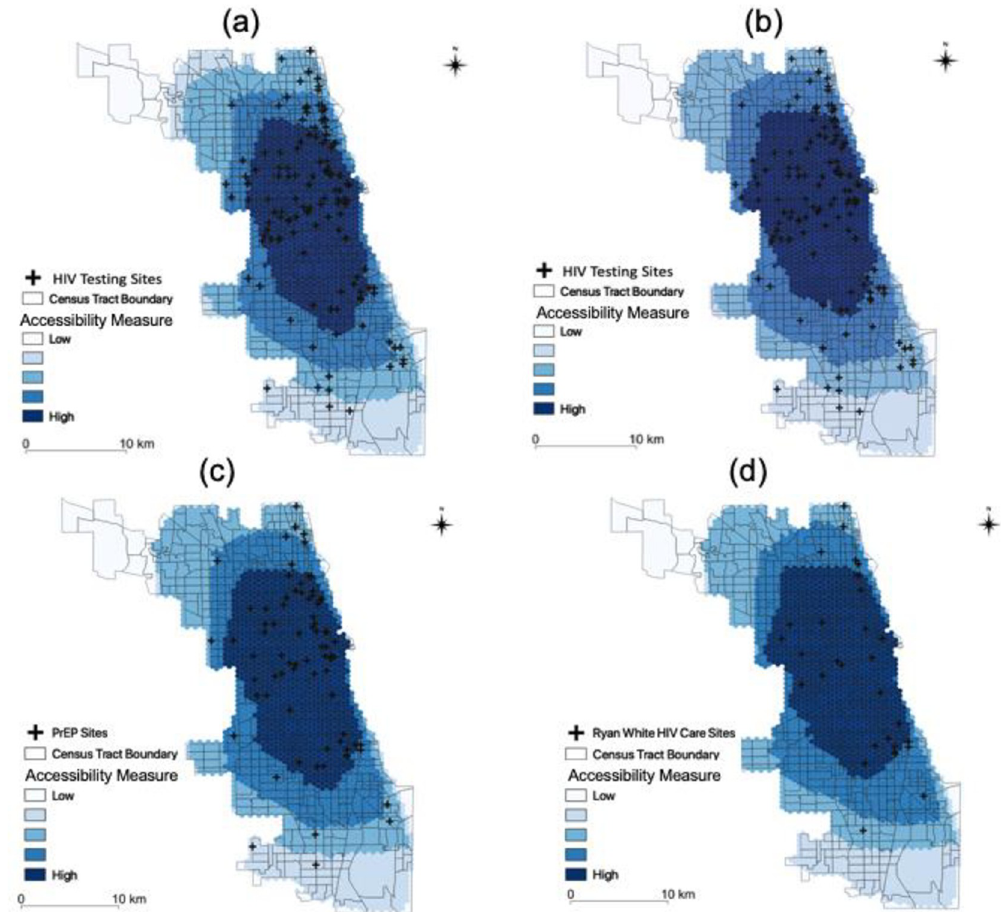
Fig 7. Spatial accessibility in Chicago. (a) Testing for MSM; (d) Testing for people aged 15 to 64; (c) Prevention for MSM; (d) Treatment for PLWH.